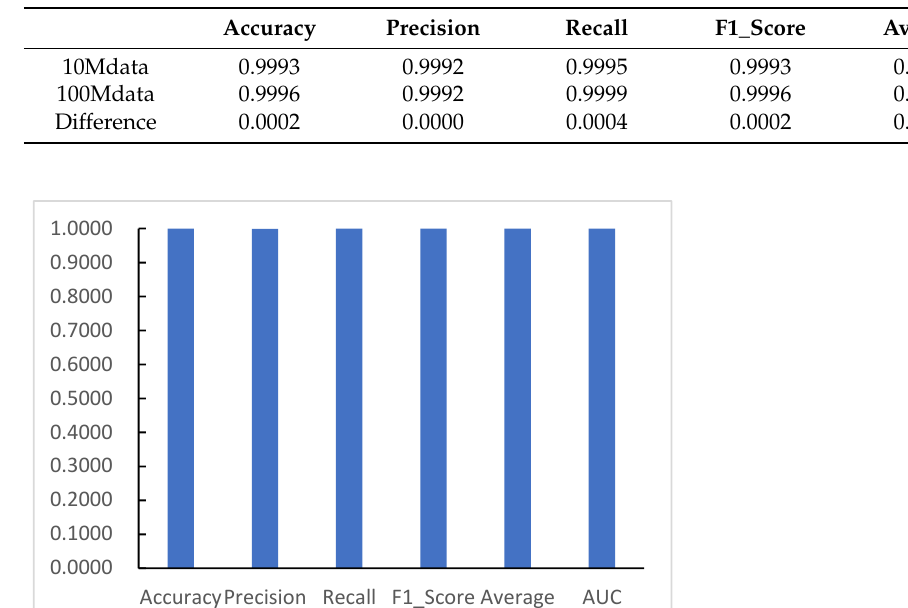
Figure 24. Performance comparison of increasing DDoS dataset. Table 12. Performance metrics for generalization capability of increasing DDoS dataset.